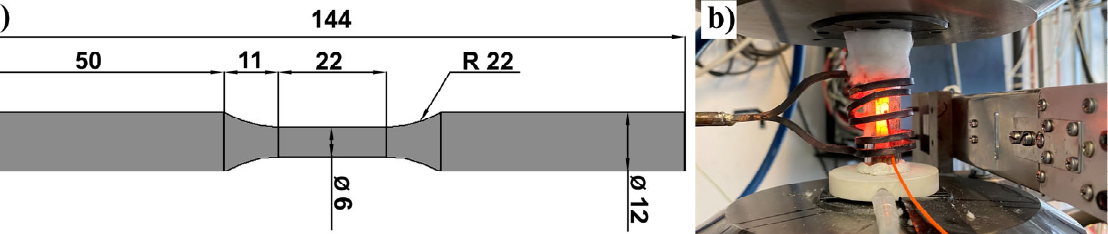
Figure 6. ( a ) The specimen drawing for high temperature tensile testing (unit: millimeter), and ( b ) the high temperature tensile testing set ‐ up.